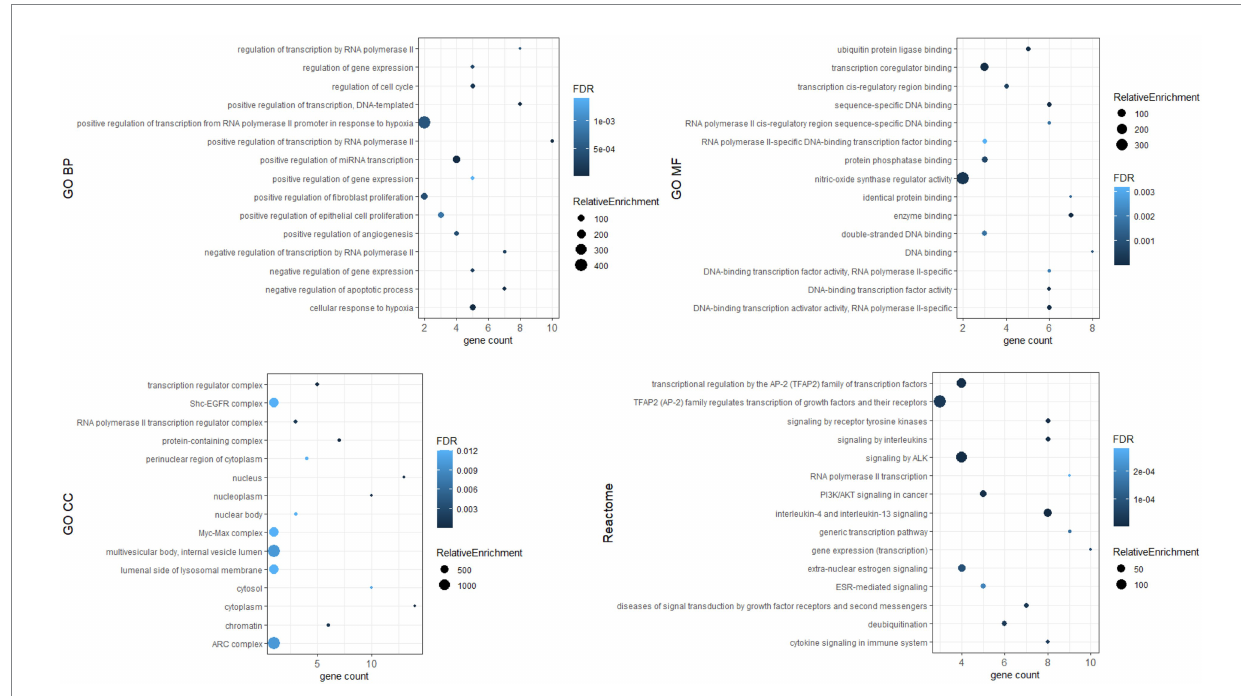
FIGURE 7 Top 15 terms for hub genes targeted by upregulated miRNAs.